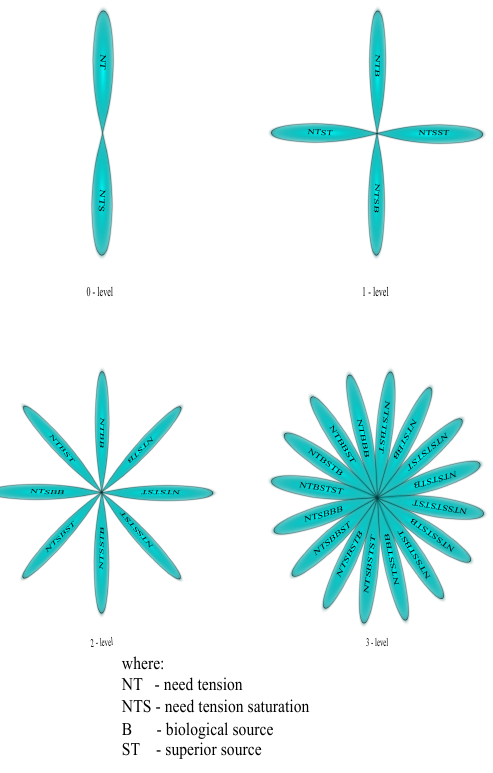
Figure 18. Coding of the tensional sources of the levels of